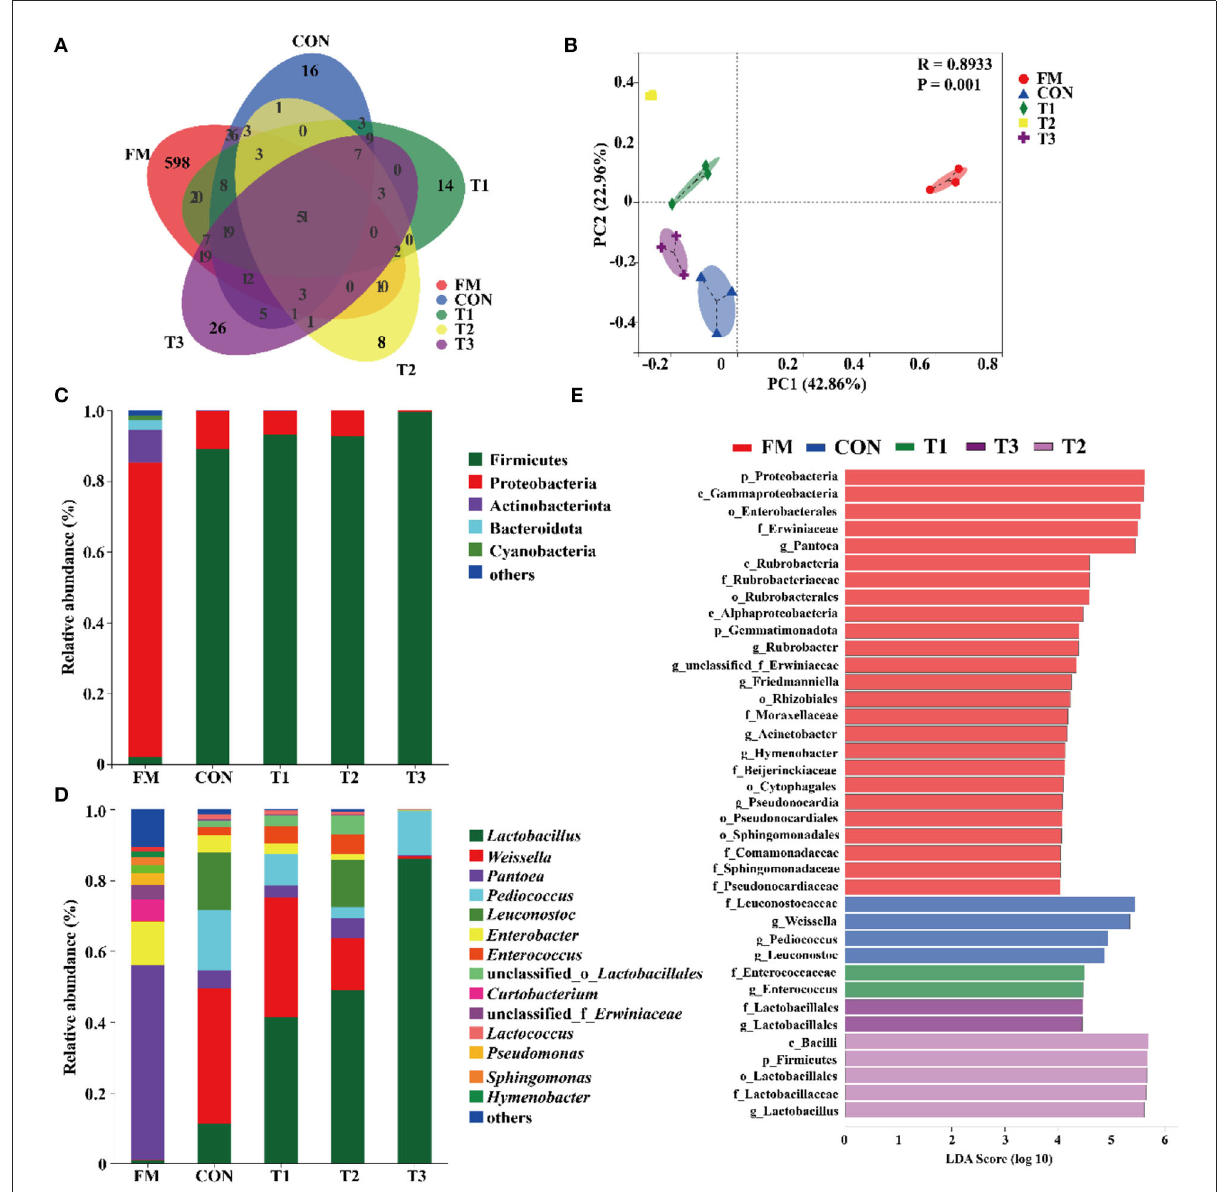
FIGURE1 Bacterial community diversities and dissimilarities of native grass silage. FM, fresh material; CON, Samples without inoculants; T1, native grass inoculated with Lactobacillus plantarum ; T2, native grass inoculated with Lactobacillus plantarum and Lactobacillus buchneri ; T3, native grass inoculated with Lactobacillus plantarum , Lactobacillus buchneri , and Pediococcus pentosaceus . (A) Venn diagram representing the unique and common OTUs. (B) The bacterial community dissimilarities in different treatments were calculated by Bray–Curtis with coordinates calculated by principal coordinates analysis. (C,D) Relative abundances of native grass silage bacterial phylum and genus across different treatments. (E) Differences of bacterial taxa in native grass silage with different